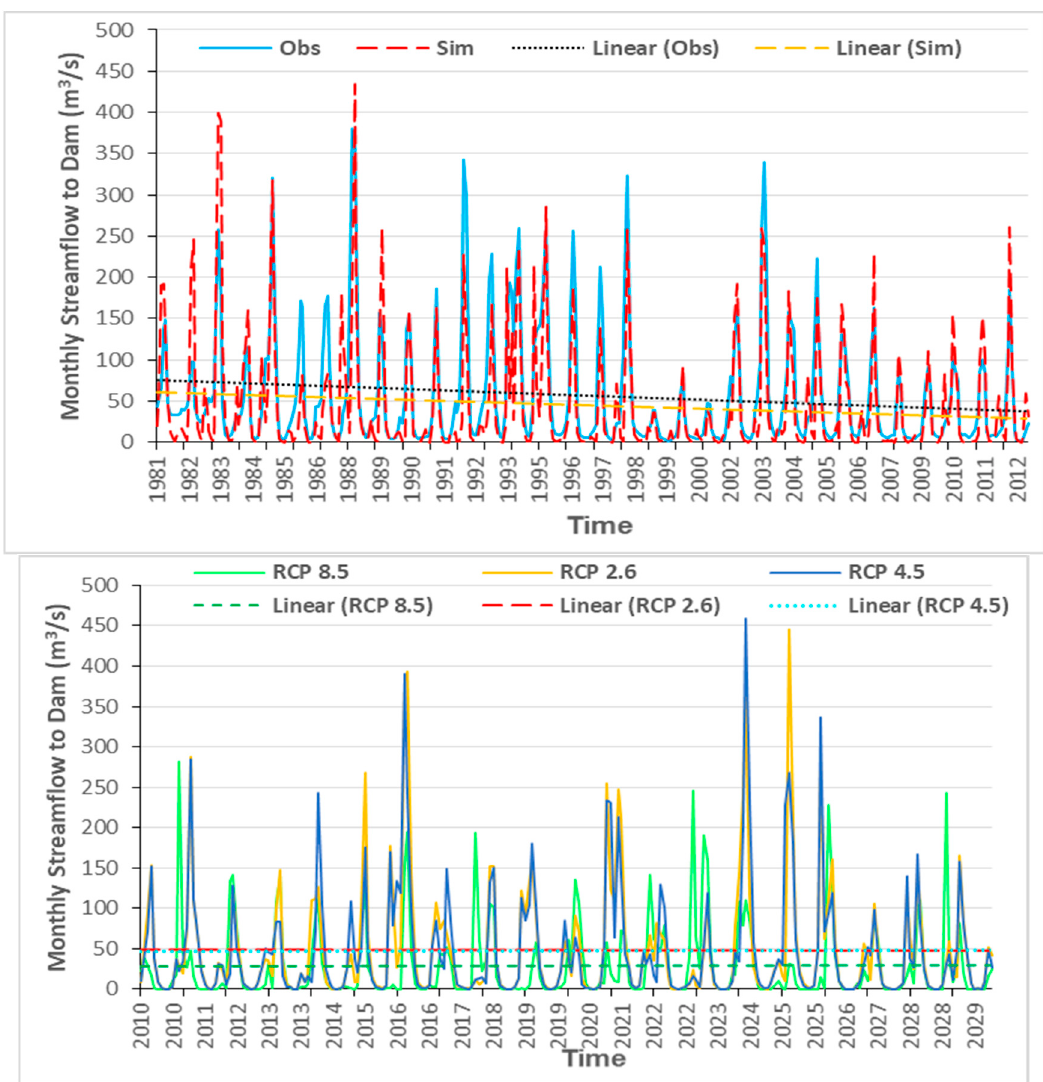
Figure 10. Monthly observed (historical), simulated (historical) together with trend lines for the historical ( top panel ) and future predicted ( bottom panel ) inflow into the Boukan Dam based on average of RCP 2.6, RCP 4.5 and RCP 8.5 climatic scenarios (see text), together with trend lines for historical and future predicted periods.